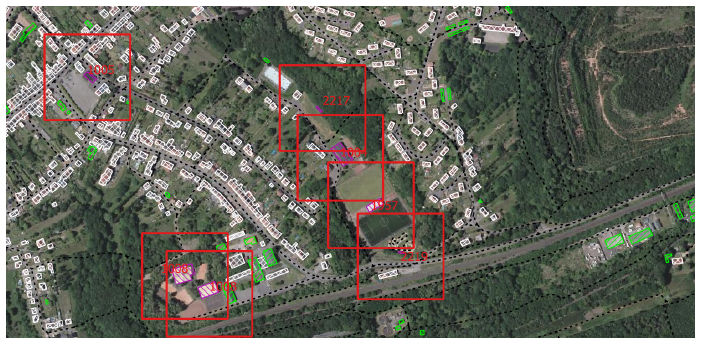
Figure 5. An example of the bounding boxes of an equal surface around POIs. Note that if two bound- ing boxes overlap more than 50%—we consider them representing the same geographic